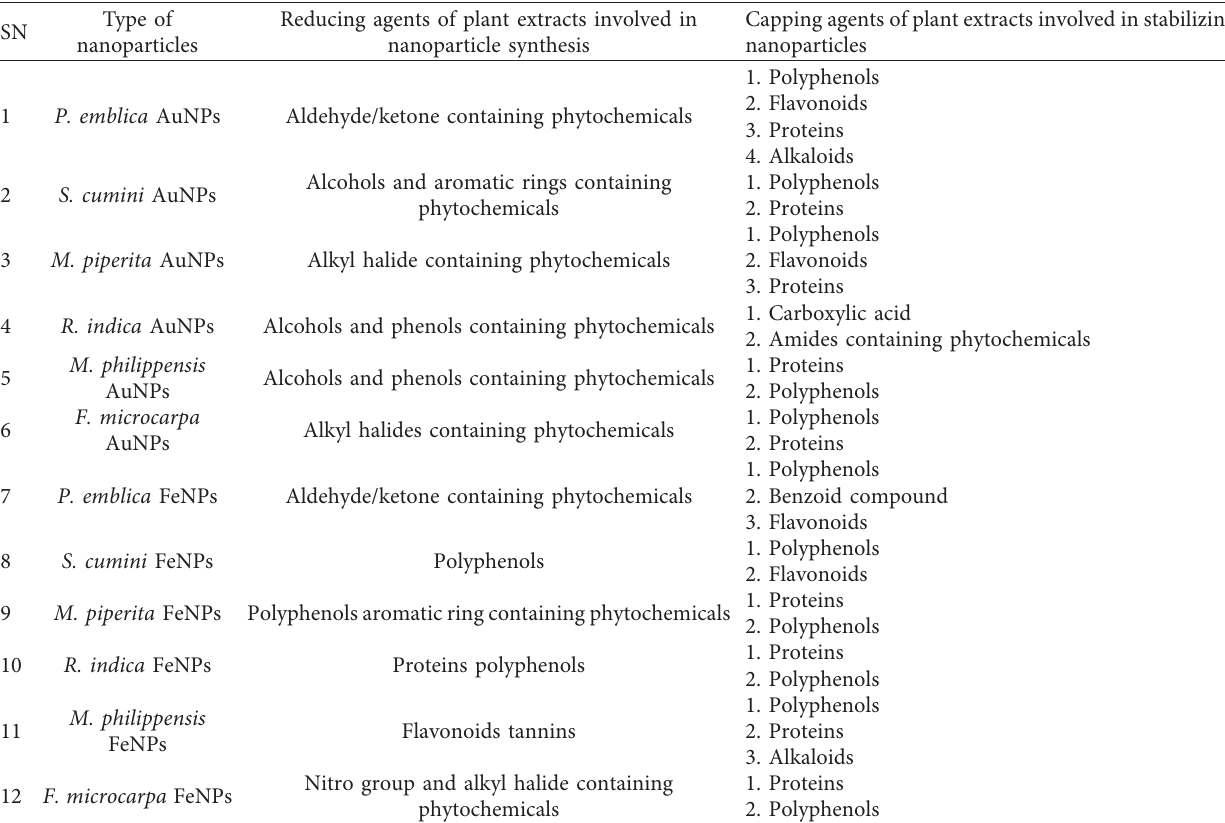
Table 1: Interpretation of FTIR